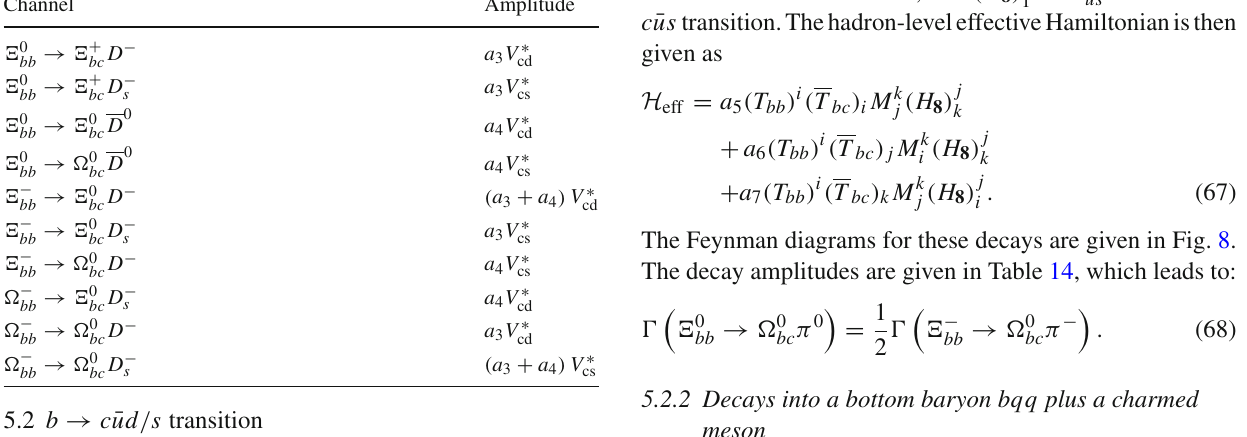
Table13 Doublybottombaryonsdecaysintoa bcq andananticharmed meson Channel